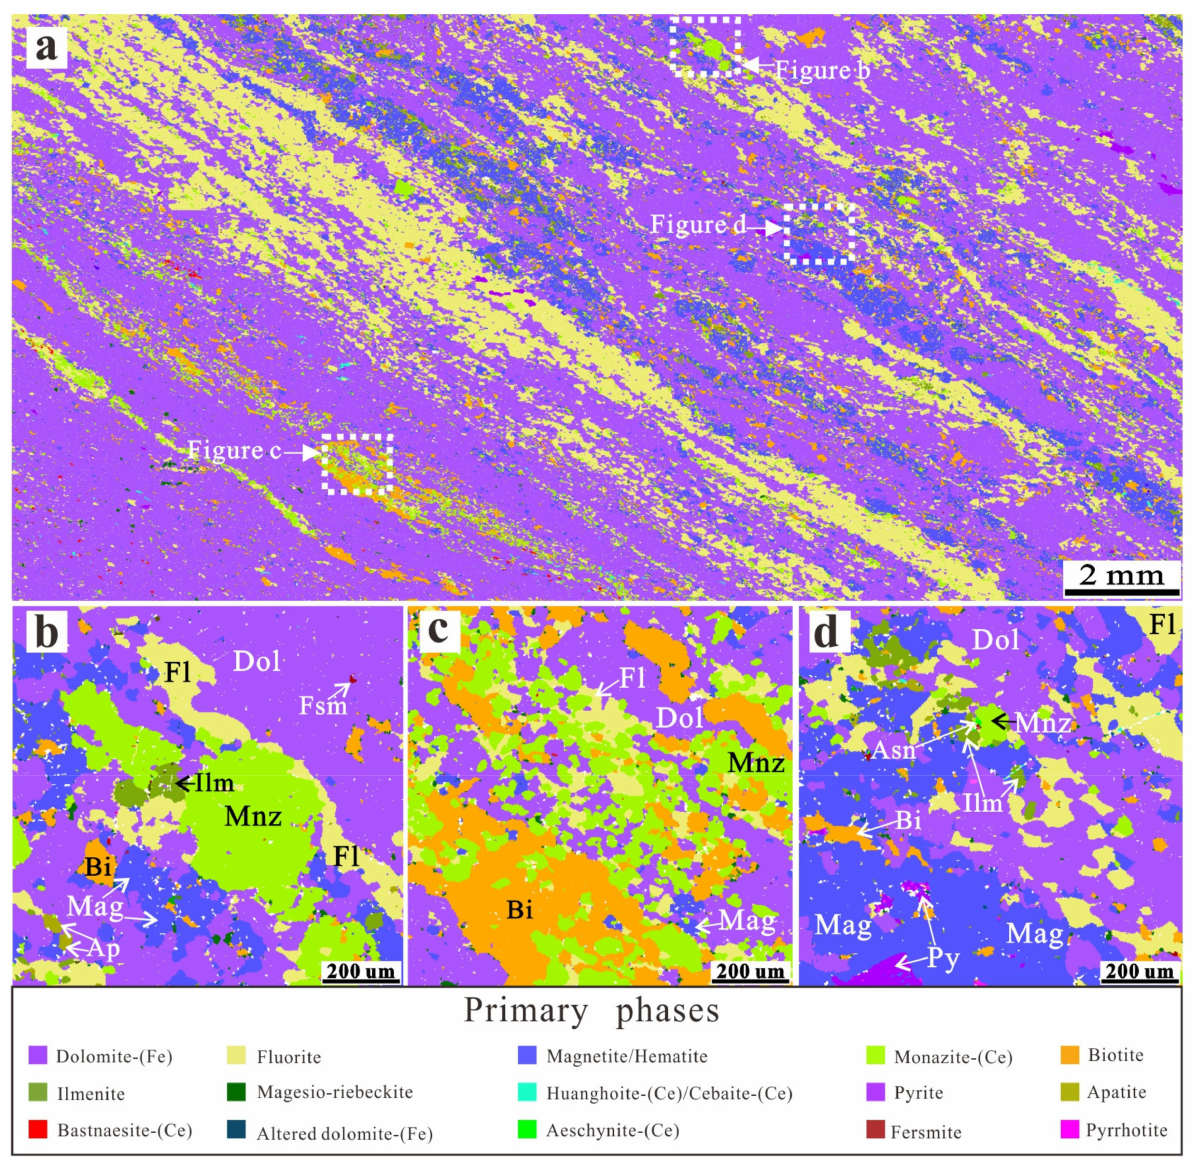
Figure 5. The TIMA false-colored mineral phase map of the 1107 m drill core sample. ( a ) the whole image of the polished thin section shows banded ore texture; ( b ) subhedral to anhedral monazite-(Ce) associated with fluorite, magnetite, and ilmenite with a granular size larger than 200 µ m in diameter, overprinted on dolomite-(Fe); ( c ) fine-grained monazite-(Ce) aggregates within the dolomite-(Fe) matrix, associated with biotite and fluorite; ( d ) scattered monazite-(Ce), associated with magnetite, ilmenite, and fluorite, overprinted on the dolomite-(Fe) matrix. Abbreviations: Dol, dolomite-(Fe); Mnz, monazite-(Ce); Fl, fluorite; Ap, apatite; Mag, magnetite; Py, pyrite; Bi, biotite; Fsm, fersmite; Ilm, ilmenite; Asn,